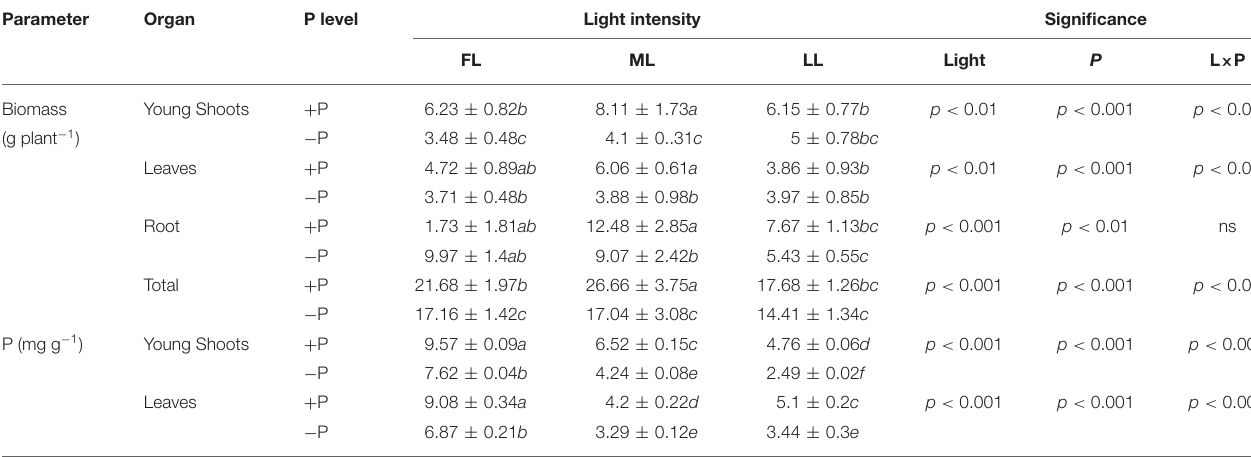
TABLE 1 | Biomass and concentrations of phosphorus (P) in the organs of Fengqing cultivar under different light intensities and phosphorous (P) levels. Parameter